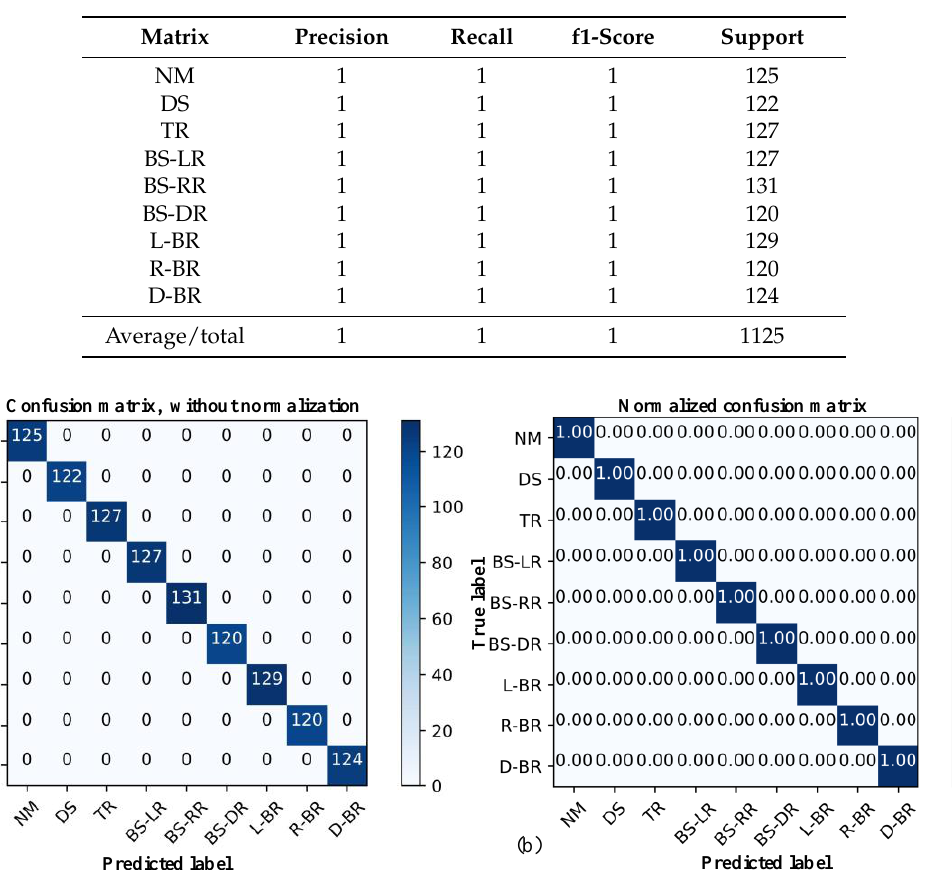
Table 8. The confusion matrix of the CNN.